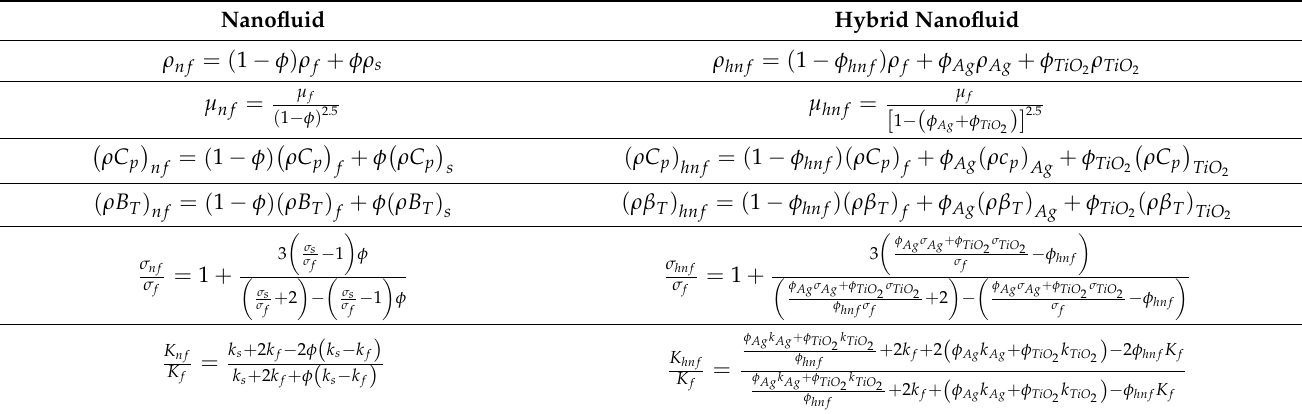
Table 1. The thermophysical boundaries of the considered